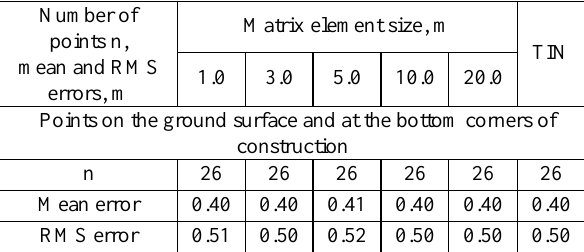
Table 5. The results of vertical positional accuracy estimation of control points obtained by 3D